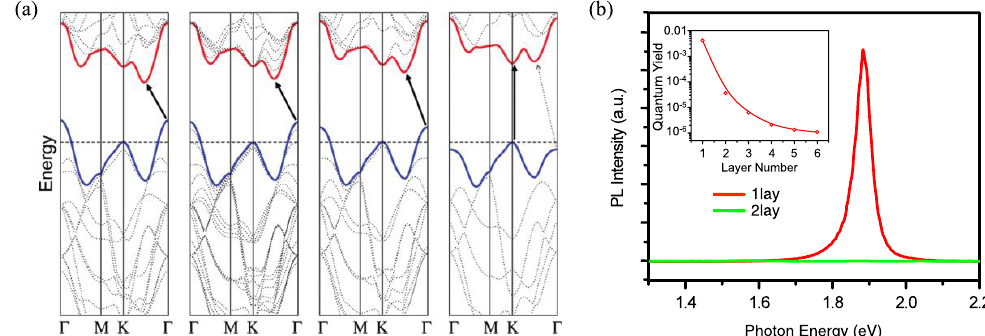
Figure 1. ( a ) Band structure calculations of bulk, four-layer, bilayer and monolayer MoS 2 (from left to right). Arrows indicate the lowest energy transitions. Reproduced with permission from [10],